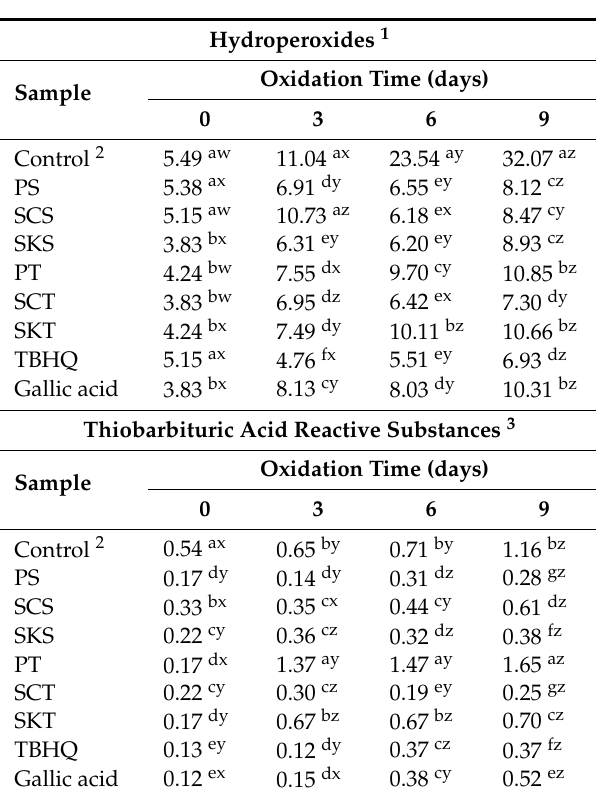
Table 3. Antioxidant effect of the extracts obtained from agroindustrial mango waste, TBHQ, and gallic acid on the formation of hydroperoxides and thiobarbituric acid reactive substances in cooked beef homogenate stored at 4 ◦